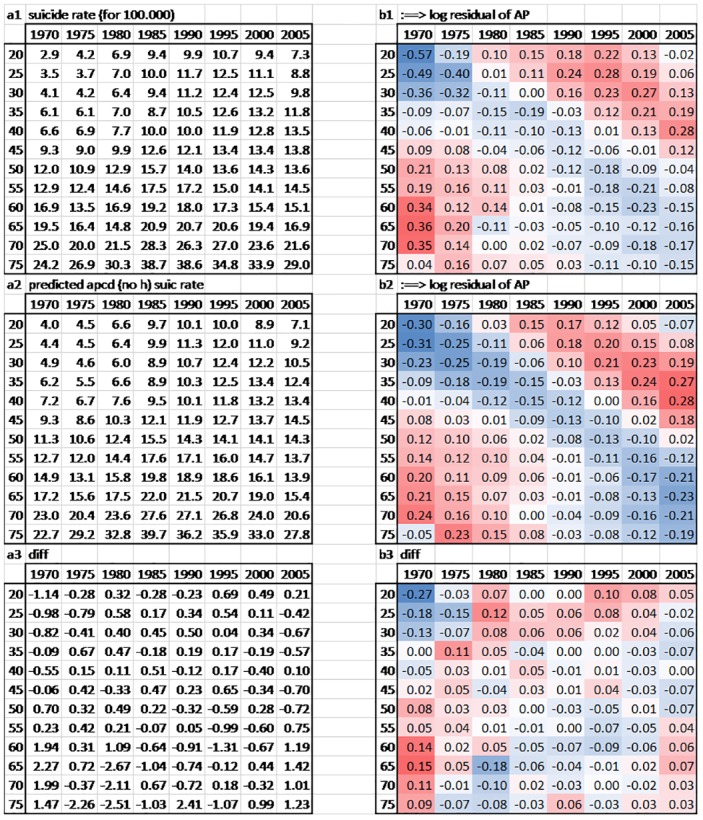
Hypothetical versus empirical suicide fluctuations: The Spanish case.Note. We compare three datasets: The actual empirical dataset a1 (suicide rates per 100,000 population), a simulated dataset without changes in intensity of cohort effects (i.e. hysteresis/stability over the life course) a2, and the difference between cells a3. Now consider b1 and b2, the residuals of the logged values of datasets a1 and a2 in the model (AP) (we suppress the linear combination of age and period dummies). b1 shows some cohort effects, that are ‘imperfect’ compared to b2 the expected values under the hypothesis of a pure APC without h effect. In these tables, the red cells are the high values of suicide and the blue cells the relatively protected groups. b3 presents the differences between empirical b1 and theoretical b2, and following the diagonally changing colours, we can detect temporal stability/changes of cohort fluctuations.